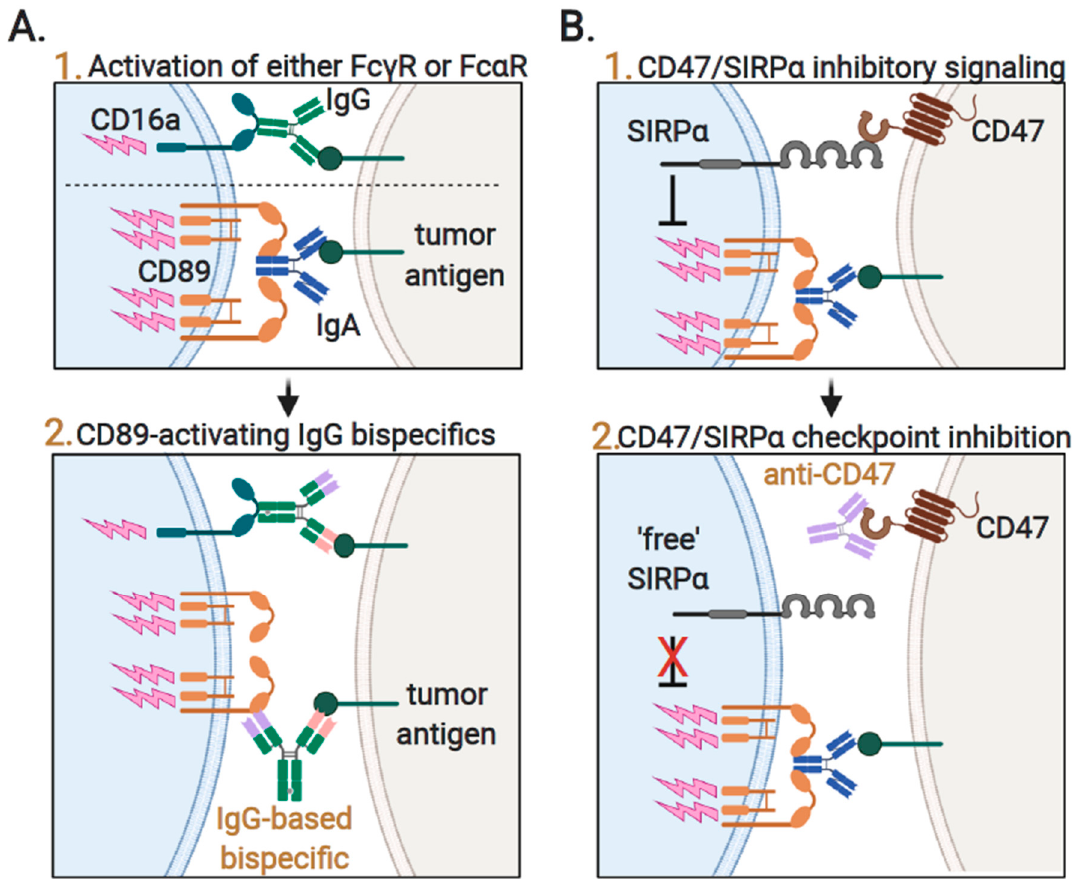
Figure 4. Antibody-based therapeutic strategies to improve neutrophil-mediated anticancer immune responses. ( A ) panel 1. Whereas IgA outperforms IgG in terms of neutrophil activation, IgGs are the